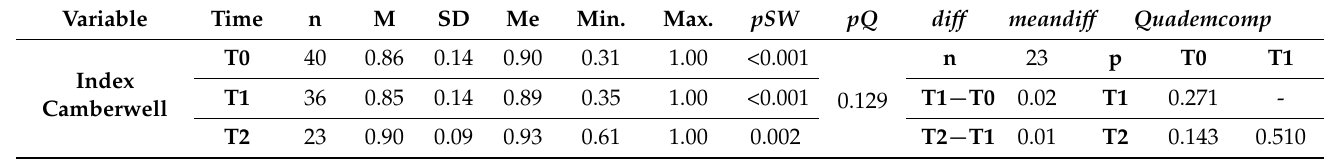
Table 2. The level of satisfaction of the needs in the G1 food group during T0, T1, T2.